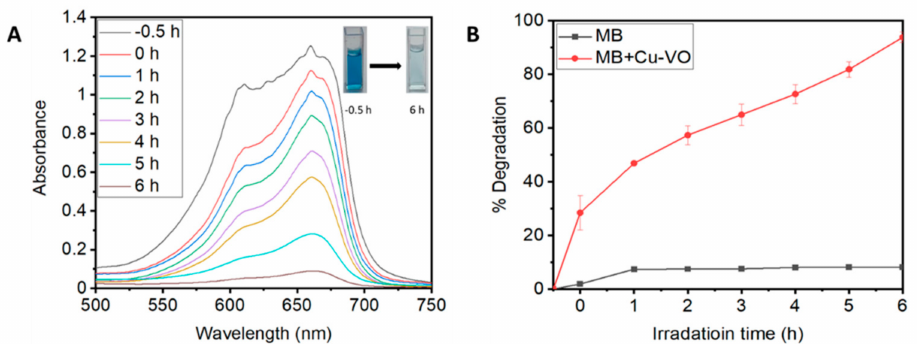
Figure 8. UV–Vis absorbance spectra ( A ) and degradation percentage of 50 µ M MB treated with Cu-VO catalyst at a different time interval ( B ) The dye degradation assay was performed three times, and the degradation percentage plot is the average of three independent